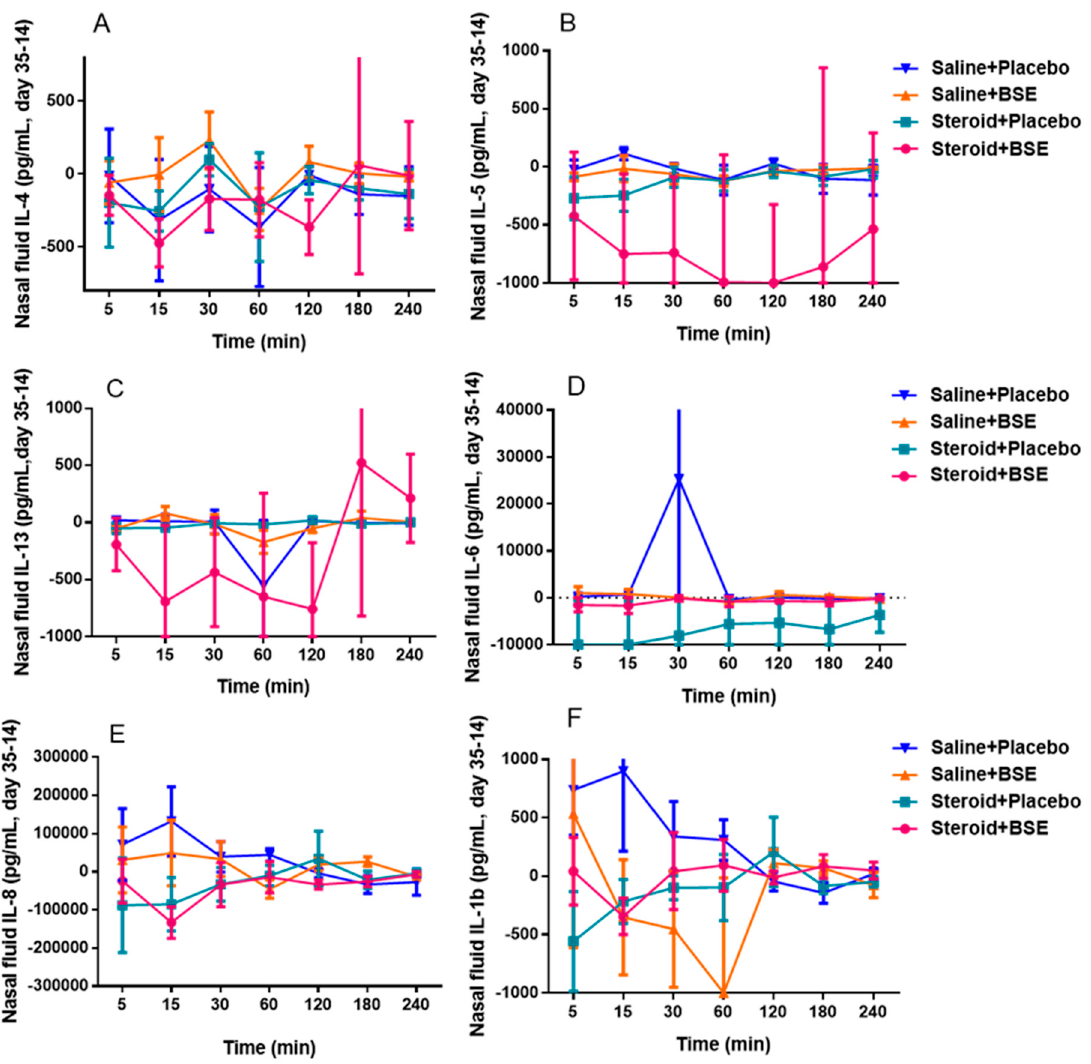
Figure 4. Differences between day 14 (before intervention) and day 35 (completion of intervention) for nasal mucus cytokine levels, divided into T2 cytokines ( A – C ) and other cytokines ( D – F ).